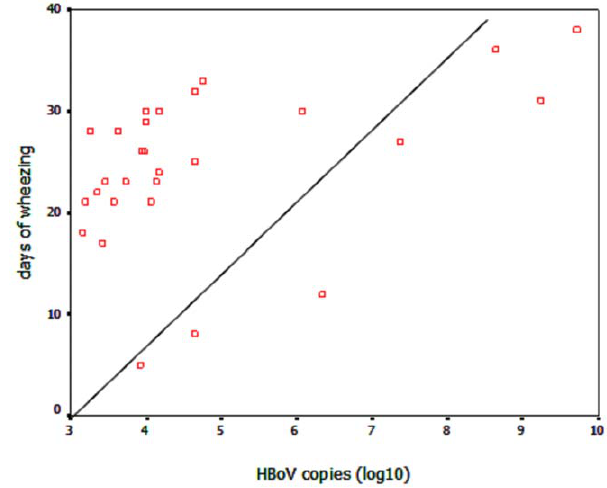
Figure 2. Correlation between HBoV viral load and days of wheezing. HBoV viral load was correlated to the days of presented wheezing. Correlations were made with Spearman’s two-tailed rank correlation in addition to Pearson’s linear regression two-tailed analysis. Correlation coefficient=0.538, P=0.003. doi:10.1371/journal.pone.0034353.g002 PLoS ONE |